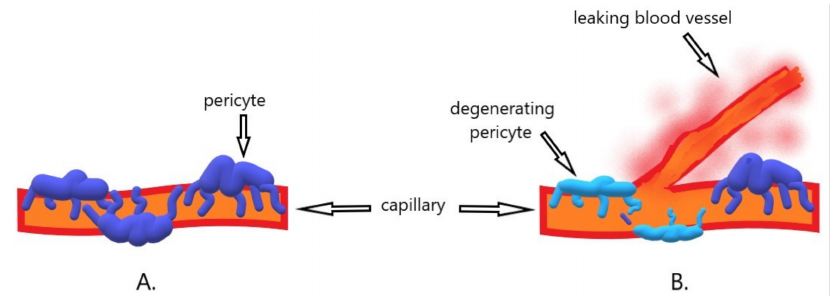
Figure 2. Schematic illustration of the mechanism of diabetic retinopathy. ( A ). The presence of pericytes ensures proper functioning and stability of capillary walls. ( B ). Due to the hypoxia of the retina and the expression of angiogenic factors, new branches of the already existing vessels are formed through angiogenesis. Due to the atrophy and degeneration of the pericytes, the capillary walls become fragile, which leads to leakage and then edema of the